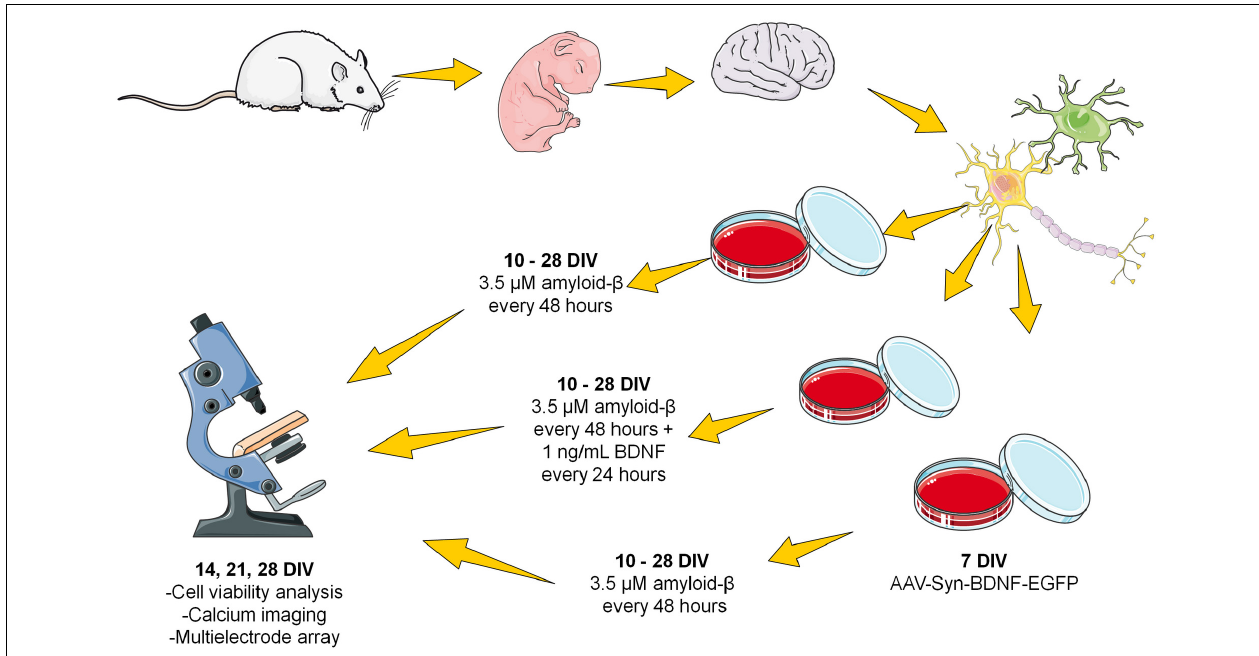
FIGURE 1 | Scheme of the chronic amyloid- β application. The fibrillar amyloid- β was added to the culture medium every 48 h (i.e., after each change of culture medium) at a final concentration of 3.5 µ M from DIV 10 to DIV 28.